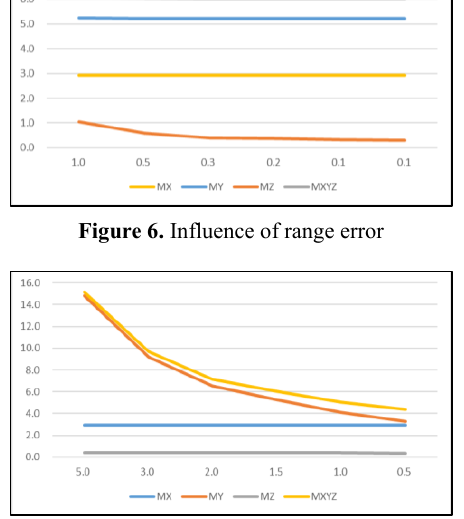
Figure 7. Influence of pointing angle